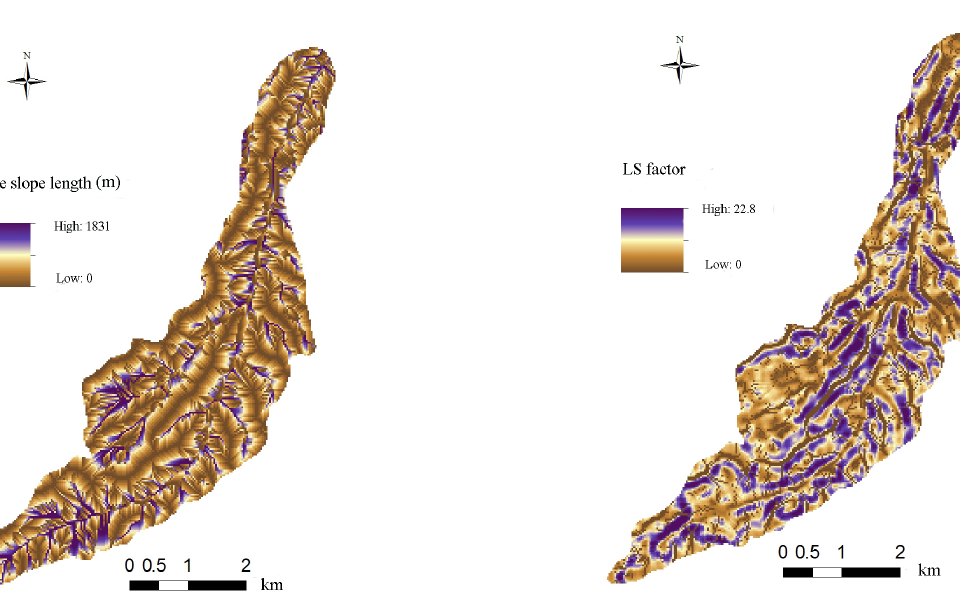
Figure 8. Spatial distribution of slope length.